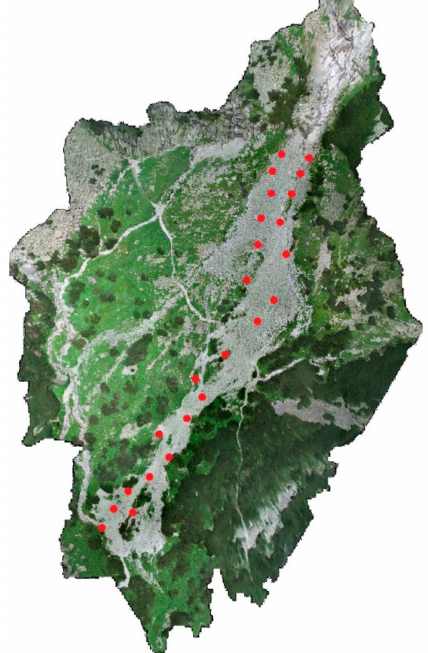
Figure 8. Leica P40